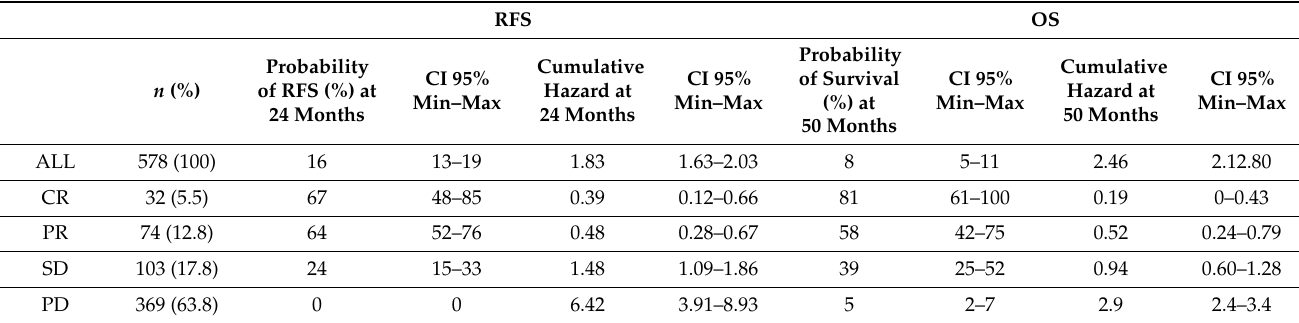
Table 2. RFS and OS analysis of the whole cohort. Probability of relapse free survival and probability of survival after immunotherapy received at inclusion at the INT-NA.